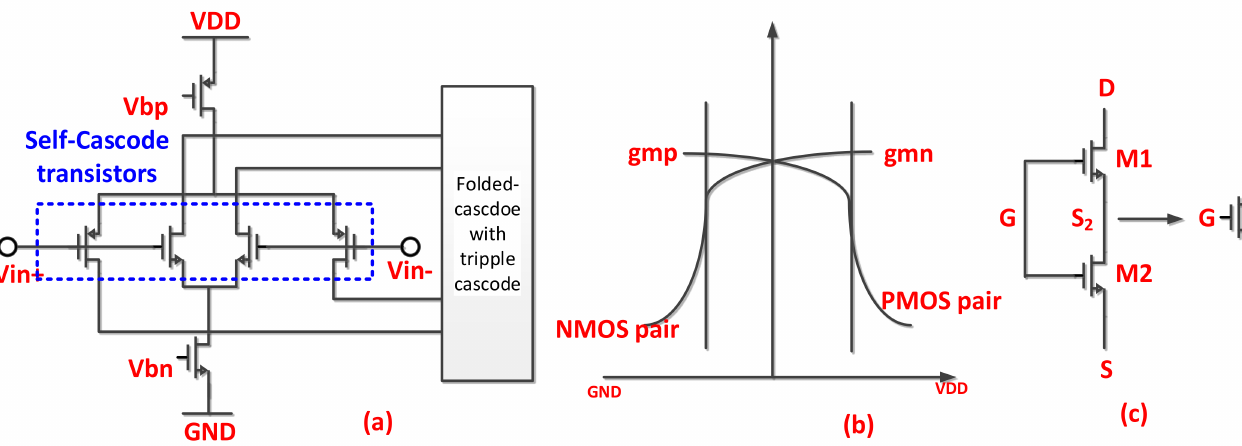
Figure 2. The rail-to-rail CMOS input stage with nMOS and pMOS differential pairs in parallel is adopted as the input stage: ( a ) Schematic and ( b ) the transconductance versus input common-mode range and ( c ) self-cascode input